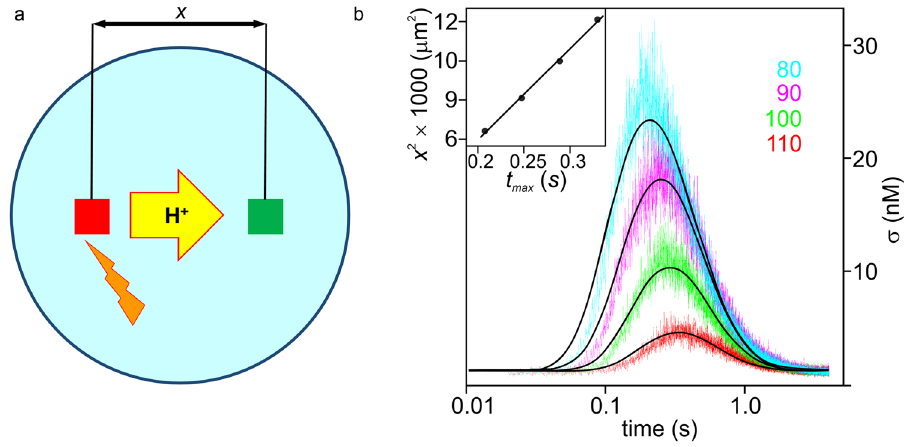
Figure 2. Monitoring proton surface diffusion. ( a ) The membrane bound caged protons were released by a UV flash from the area in the red square (10 × 10 µ m 2 ) and their arrival was observed as a change in fluorescence intensity in the green square (10 × 10 µ m 2 ). The light emitted by the lipid-anchored pH sensor fluorescein was collected using a 40x water immersion objective and a 515 nm high-pass filter. ( b ) The proton concentration σ adjacent to the membrane is monitored as a function of the time that elapsed after the flash at the indicated distances x (in µ m) from the observation site (19 °C). σ has been calculated from the fluorescence intensity of membrane anchored fluorescein according to a calibration curve (Supplementary Fig. S1). It reaches it maximum at time t max , which according to equation (1) obeys: t max = x 2 /4 D − k off t max2 . When the last term is small, t max depends linearly on x 2 , as shown in the inset. The colored traces are averaged data from at least 10 individual uncaging reactions each. The black lines represent a global fit to average traces at four distances of the non-equilibrium model. Therefore equation (1) was modified to take into account the finite sizes of release and detection zones (equation (S3), Supplementary Fig. S2). The global fit parameters, D l = 5.1 × 10 − 5 cm 2 s − 1 and k off = 2.3 s − 1 , are common to all curves, whereas the amplitude A neq was allowed to vary ( ±